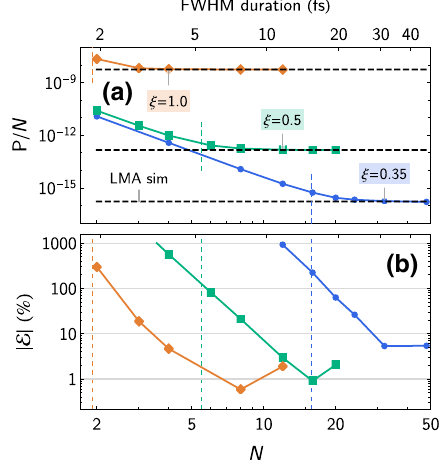
Fig. 4 a Paircreationprobability P foraphotonwithenergyparameter η = 0 . 2 colliding with a plane-wave, CP laser pulse of peak amplitude ξ and duration equivalent to a number of wavelengths N : results from QED for ξ = 0 . 35 (blue), ξ = 0 . 5 (green) and ξ = 1 . 0 (orange) and LMA-based simulations (black, dashed). b Percentage error made by the simulations. Vertical, dashed lines give the N at which the lin- ear Breit–Wheeler contribution from the pulse envelope surpasses the multi-photon scaling from the